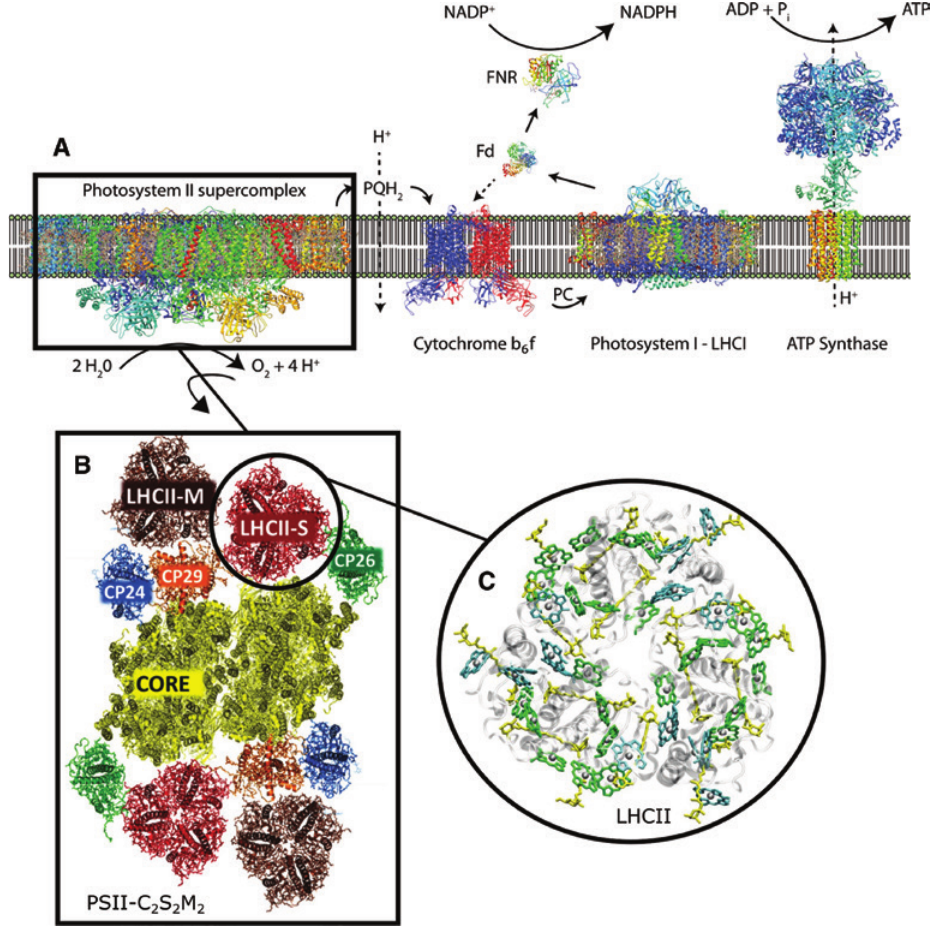
Figure 1: The photosynthetic apparatus of higher plants. (A) The thylakoid membrane, with the main photosynthetic supramolecular complexes, photosystems I and II, cytochrome b redox reactions. (B) Top view of the PSII C CP24, CP29, and CP26, and the LHCII antenna complexes. Adapted from Ref. [2], Copyright (2013) Springer. (C) Closer view of the LHCII antenna trimer; grey ribbons: protein backbones, green: chl a , blue: chl b chlorine rings (phytol chains are omitted for clarity), yellow: